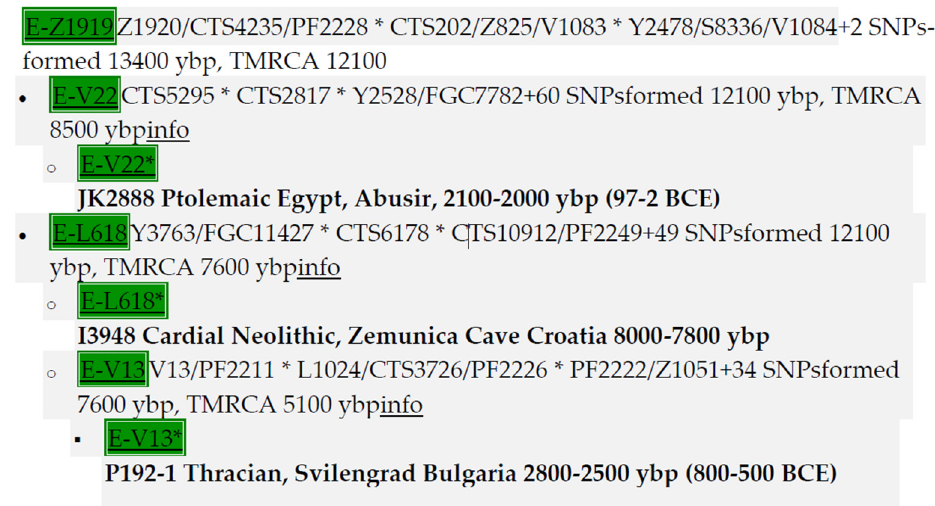
Figure 2. Phylogenetic Tree of E-M35.